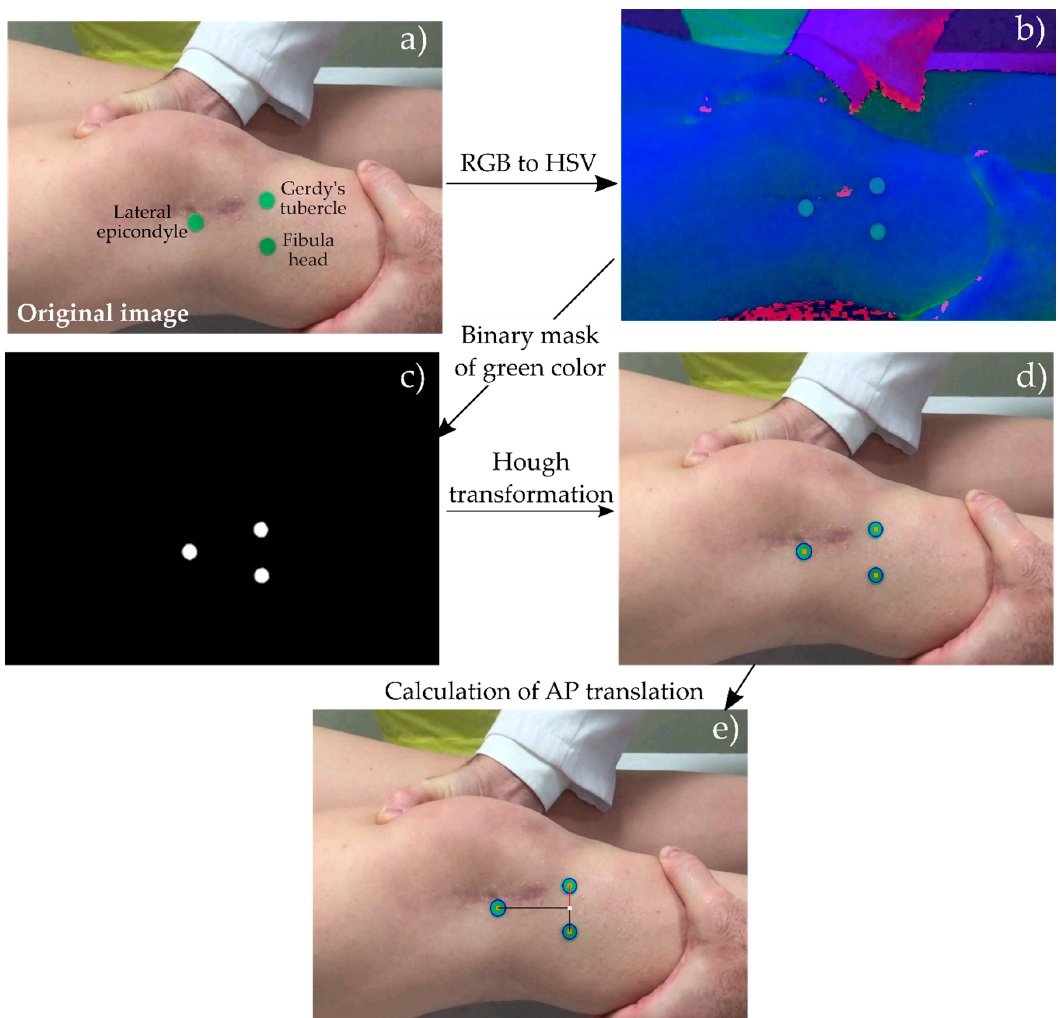
Figure 1. Steps taken by the application to obtain the anterior–posterior (AP) translation from the image of one video frame. ( a ) to ( b ) conversion from RGB (red, green and blue) to HSV (hue, saturation and value) image. ( c ) Reduction to a binary image to identify green points. ( d ) Hough transformation to obtain green circles. ( e ) Identification of all three markers and calculation of AP translation.